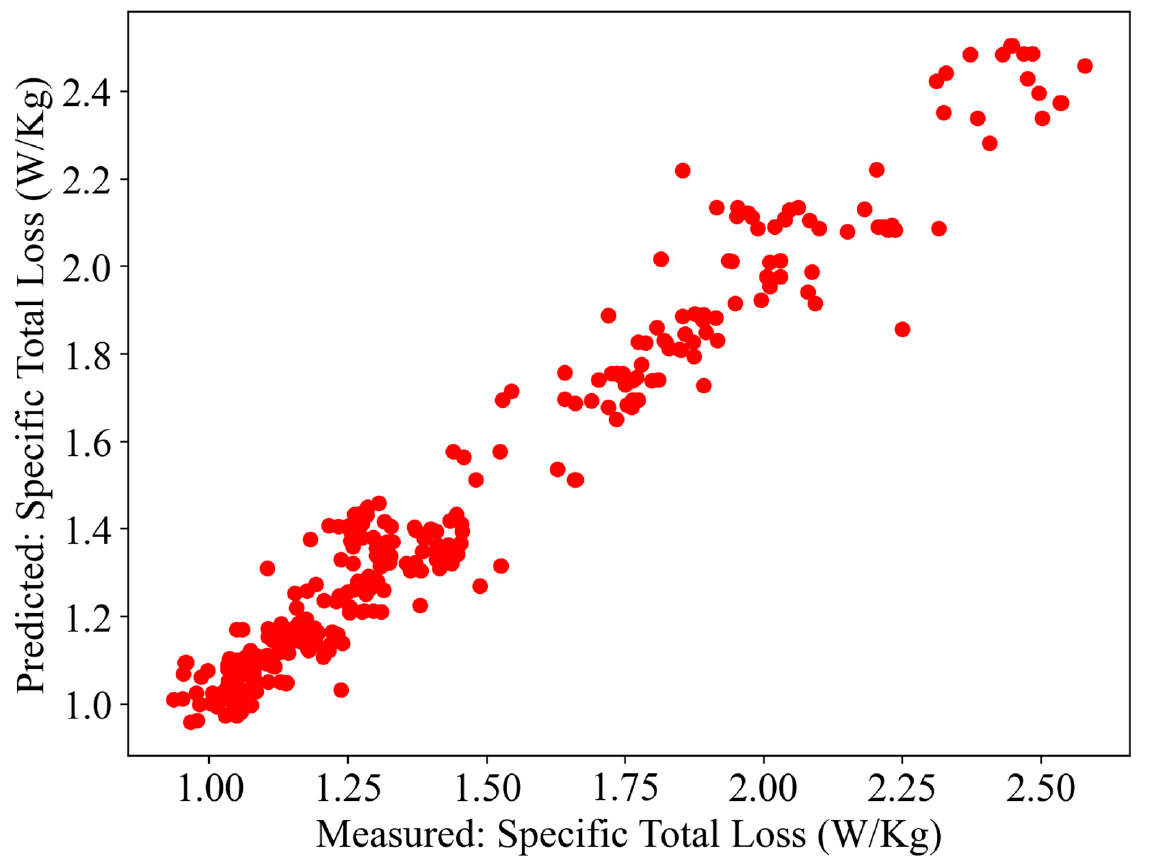
Figure 5. The training performance based on the original dataset. The X -axis represents the experi- mental specific total loss and the Y -axis presents the predicted ones. The closer these solid circles to the diagonal, the smaller the difference between the predicted value and the experimental value.